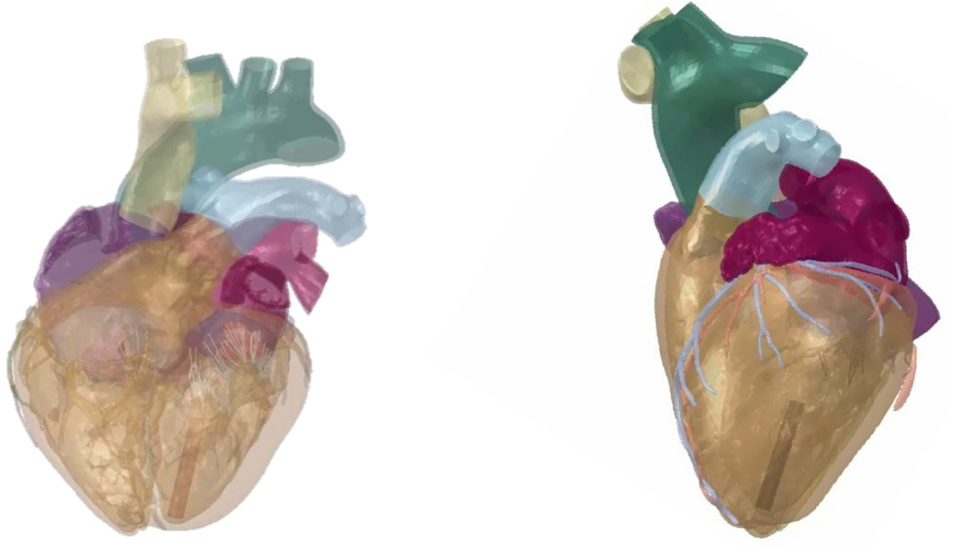
Figure 1. Leadless pacemaker is positioned at the apex region of the left ventricle in LHHM. (Left) frontal view, (Right) left view.